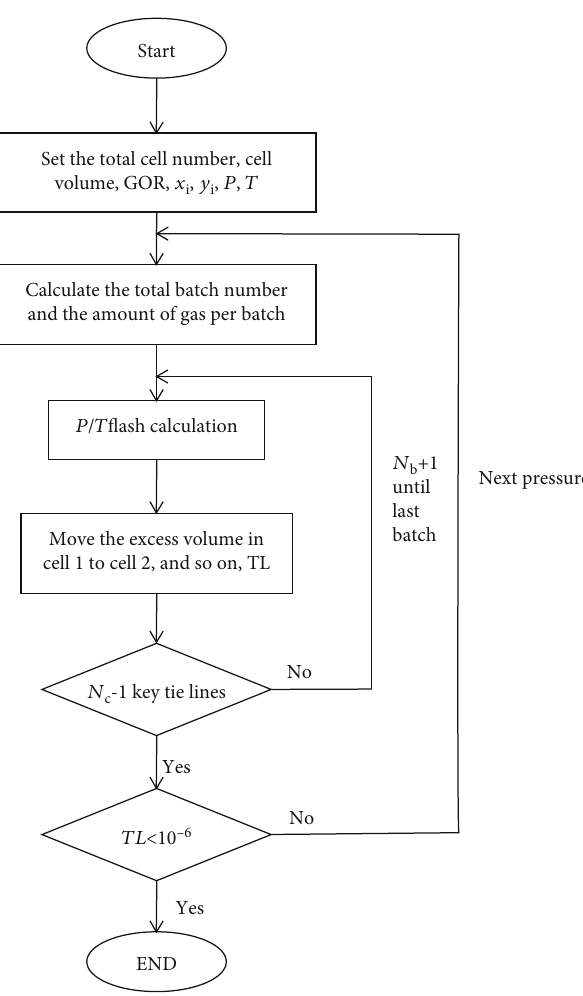
Figure 2: Flowsheet diagram of MMP prediction algorithm. Table 1: Oil and gas compositions and PR-EOS properties for Cases 1a and 1b [16, 17,